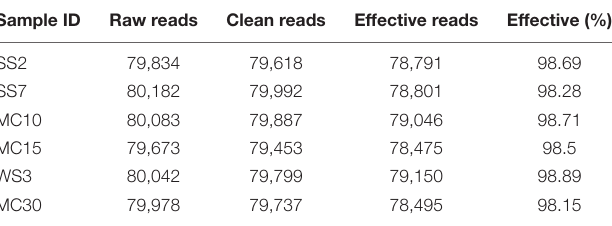
TABLE 2 | The data of ITS genes high-throughput sequencing.